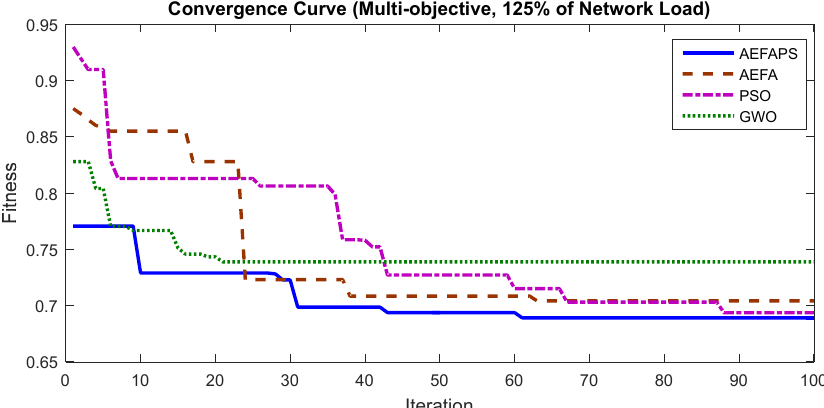
Figure 13. Convergence curve of the four methods in many-criteria reconfiguration of an unbalanced 33-bus network (125% of network nominal load).